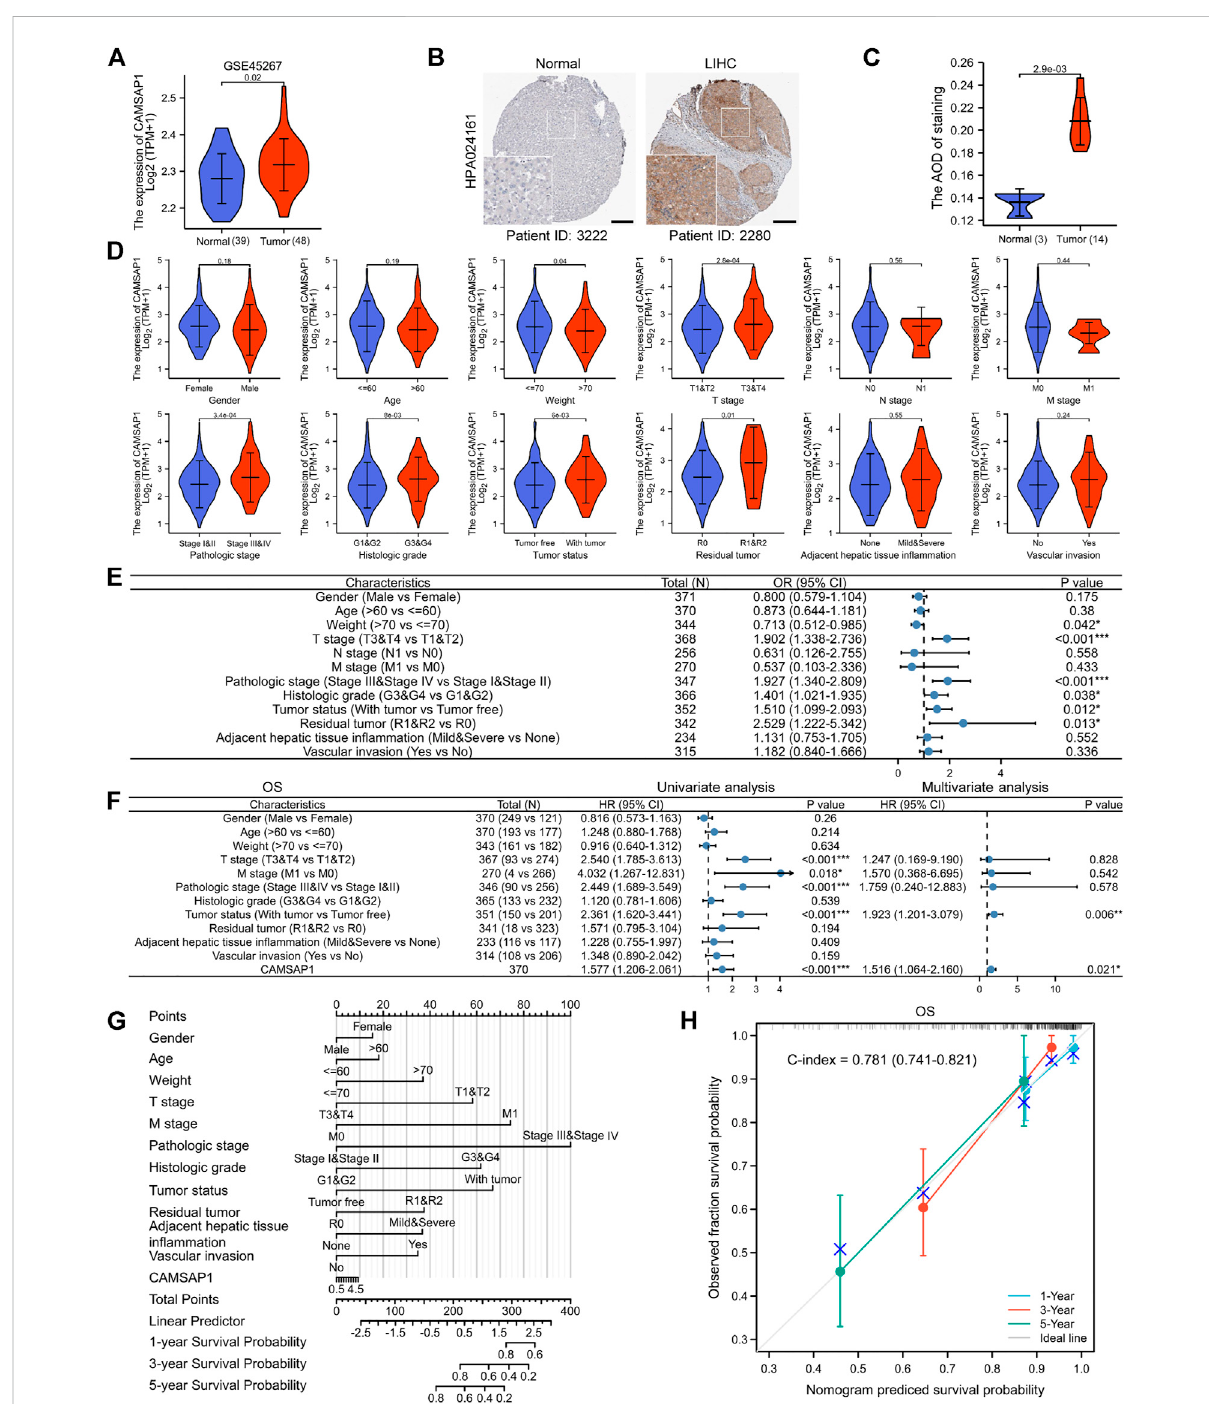
FIGURE 4 Overexpressed CAMSAP1 leadstoadverseclinicaloutcomesinadvancedLIHC. (A) Theexpressionof CAMSAP1 inLIHCfromtheGEOdatabase. (B) IHC images of CAMSAP1 proteins with antibody HPA024161 in normal and LIHC tissues from the HPA database. Scare bar, 200 μ m. (C) Statistical analysis of CAMSAP1 IHC intensity. (D) Violin plots of correlation between CAMSAP1 expression and clinical features. (E) A forest plot of univariate Logistic regression analysis of the correlation between CAMSAP1 expression and clinical features. (F) A forest plot of univariate and multivariate Cox regression analyses with OS. * p < 0.05, ** p < 0.01, *** p < 0.001. (G) A nomogram prediction model with 1-, 3-, and 5-years OS. (H) Nomogram calibration analysis with